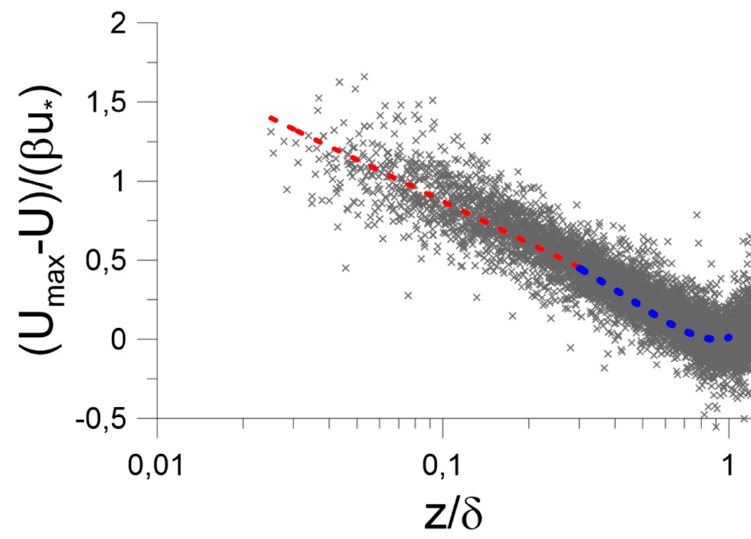
Figure 3. Velocity profiles in self-similar variables (6). Approximation of the experimental data by formula gives u β (see formula (8)) and β , and then, using the obtained values of * the roughness parameter and surface wind speed were determined: